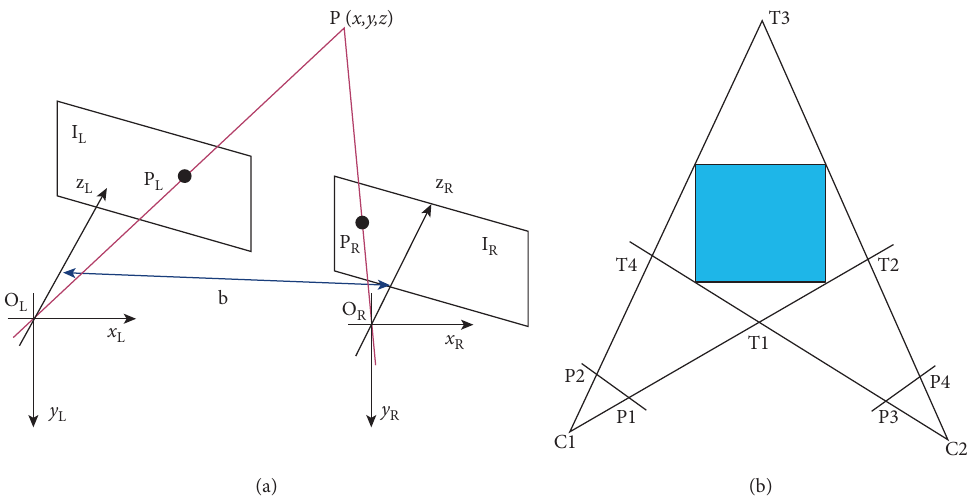
Figure 14: Schematic diagram of binocular stereovision technology [28].